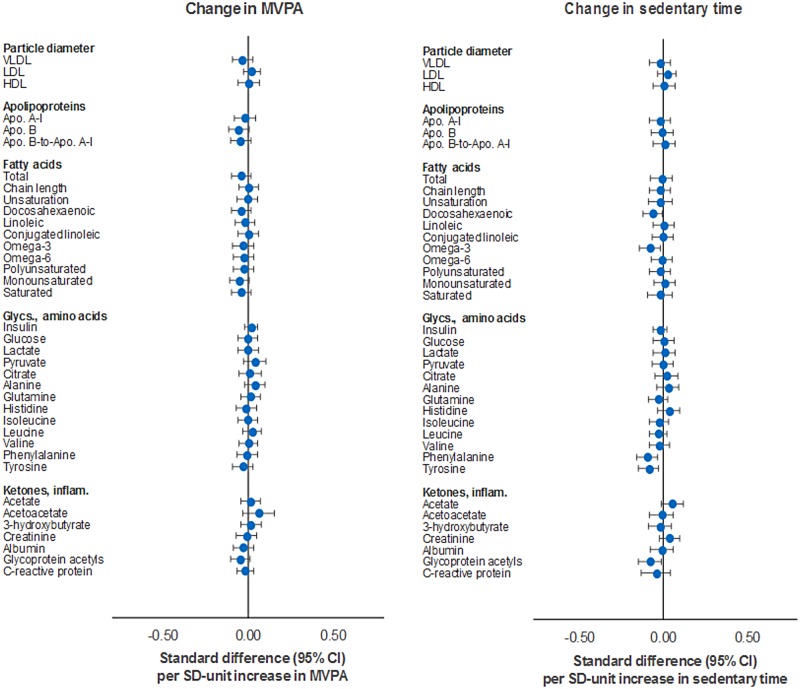
Mutually adjusted associations of change in MVPA and sedentary time with lipoprotein particle diameter, apolipoproteins, fatty acids, glycolysis factors, amino acids, ketones, and inflammatory factors at age 15y in ALSPAC.Metabolic traits are in standardised units. Change in MVPA/sedentary time defined as difference between measures at age 12y and 15y. Models are adjusted for age, sex, ethnicity, maternal education, device wear time and wear month, alternative measure (MVPA or sedentary time), and fat mass index based on change values. ALSPAC, Avon Longitudinal Study of Parents and Children; MVPA, moderate-to-vigorous physical activity.